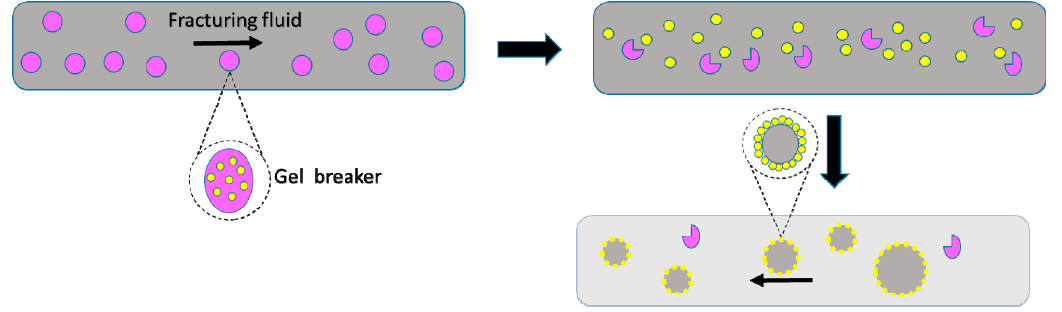
Figure 6. Back-flow process of fracturing fluid.